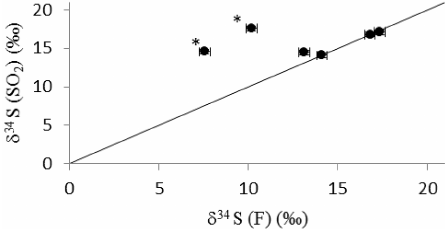
Figure 7. The isotope ratio ( δ 34 S value) for F < 0 . 49µm and SO 2 filters along with the 1:1 line. Two samples with different δ 34 S values for SO 2 and F < 0 . 49µm filter sulfate are shown with